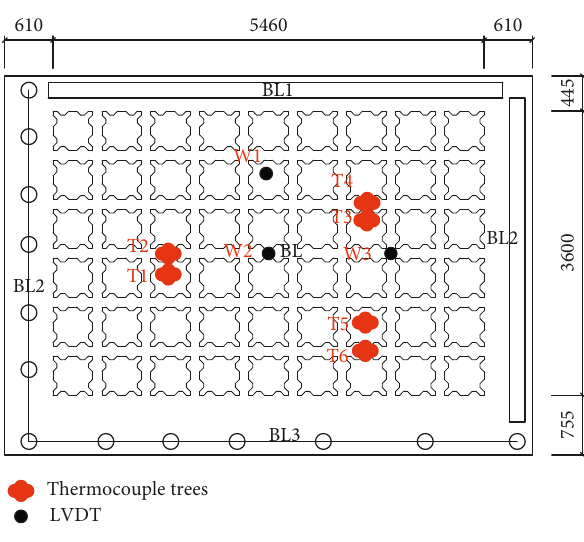
Figure 4: Structural plan dimension